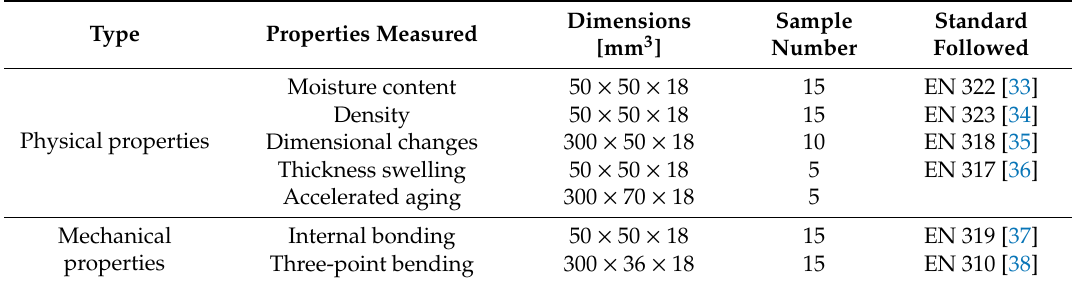
Table 1. Dimensions (length × width × thickness) of samples used for measuring di ff erent physical and mechanical properties of Medite Tricoya ® medium density fiberboard (MDF)